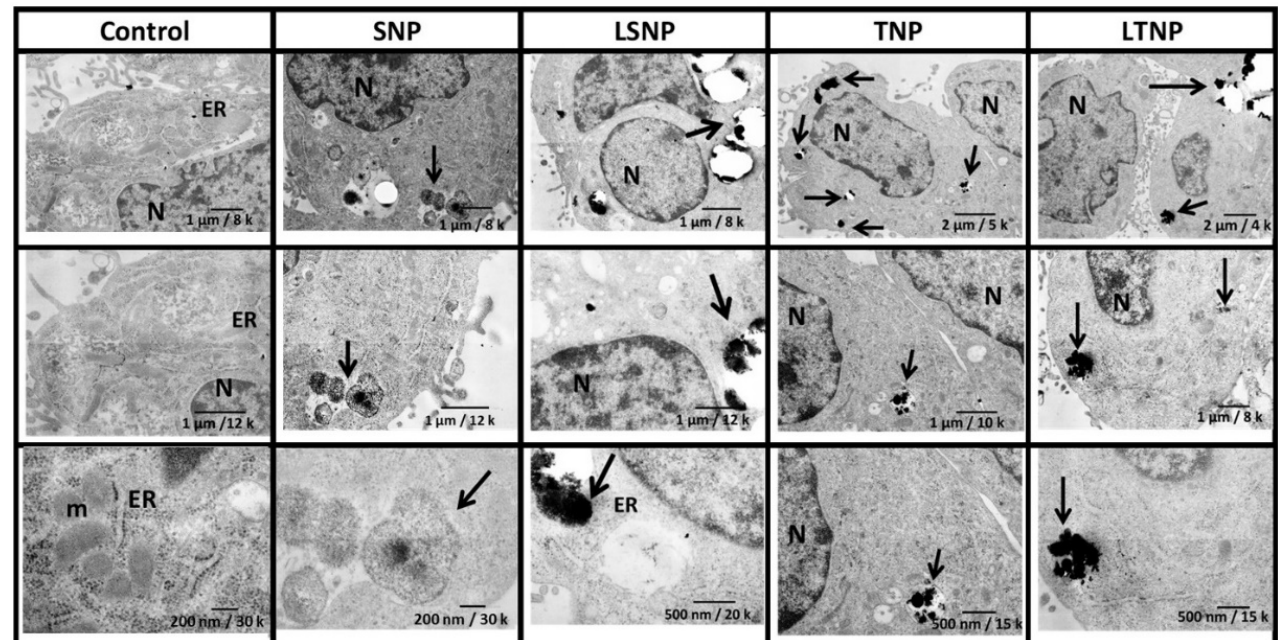
Figure 3. Nanoparticle treatment induces the intracellular accumulation of nanometer-sized electron-dense granules. C6 cells were treated with 100 µg/mL of nanoparticles for 24 h, fixed in glutaraldehyde, and processed for visualization by transmission electron microscopy. Representative images of cells are stocked in columns from lower to higher magnification. Key: endoplasmic reticulum (ER), nucleus (N), mitochondria (m), nanoparticles (arrows).